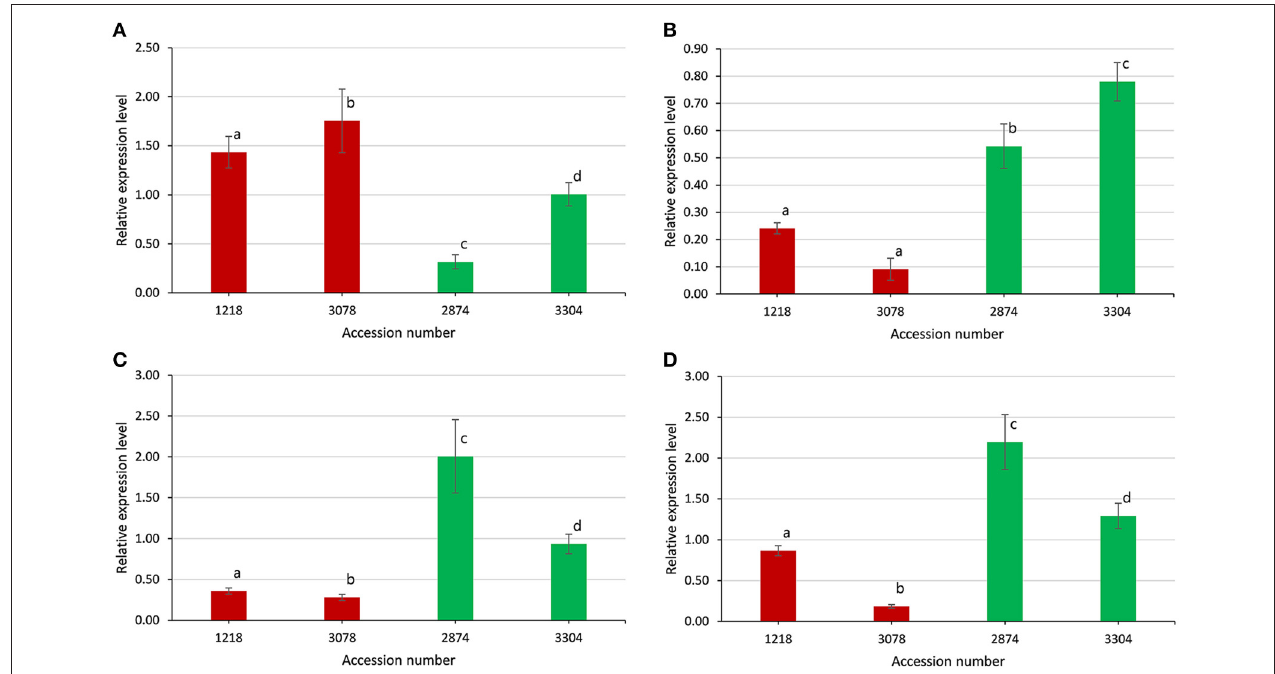
FIGURE 8 | Expression levels of four candidate genes between extremely large and small branch angle accessions. (A) Bna . TAC1 . (B) Bna . SGR1 . (C) Bna . SGR3 . (D) Bna . SGR5 . Error bars, s.d.; statistical significance was determined with a t -test, different letters above the bar represent significant a difference at 5% level.